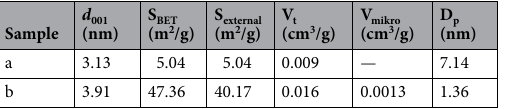
Table 4. d 001 , surface and pore parameters of (a) RMF and (b) CMMF-H2.5-400 after